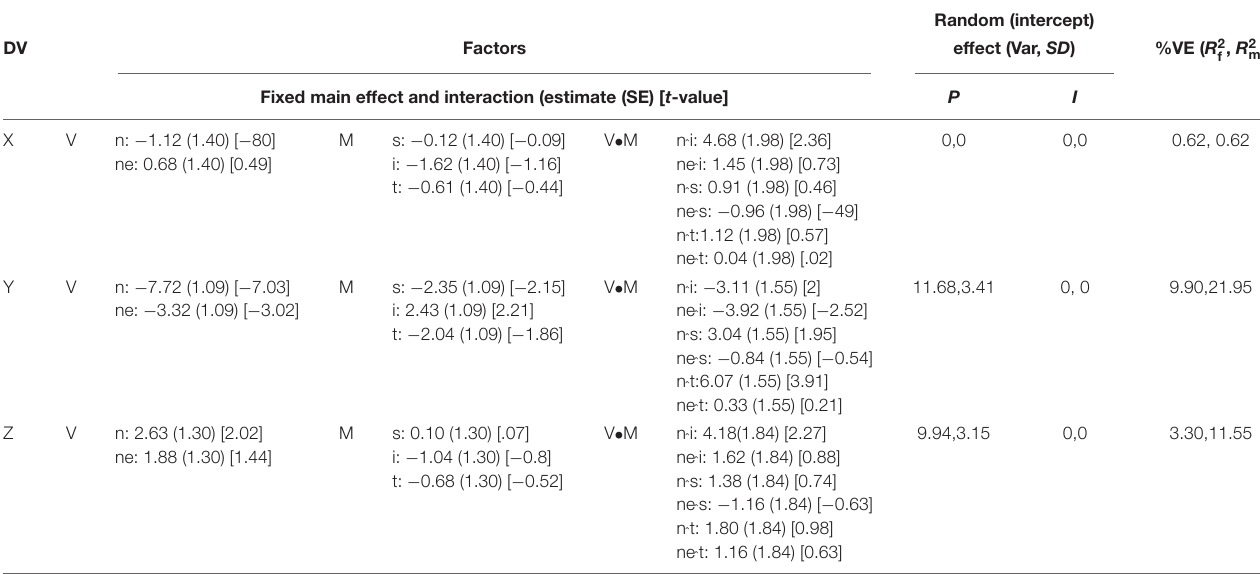
Random (intercept) , R 2 m ) f